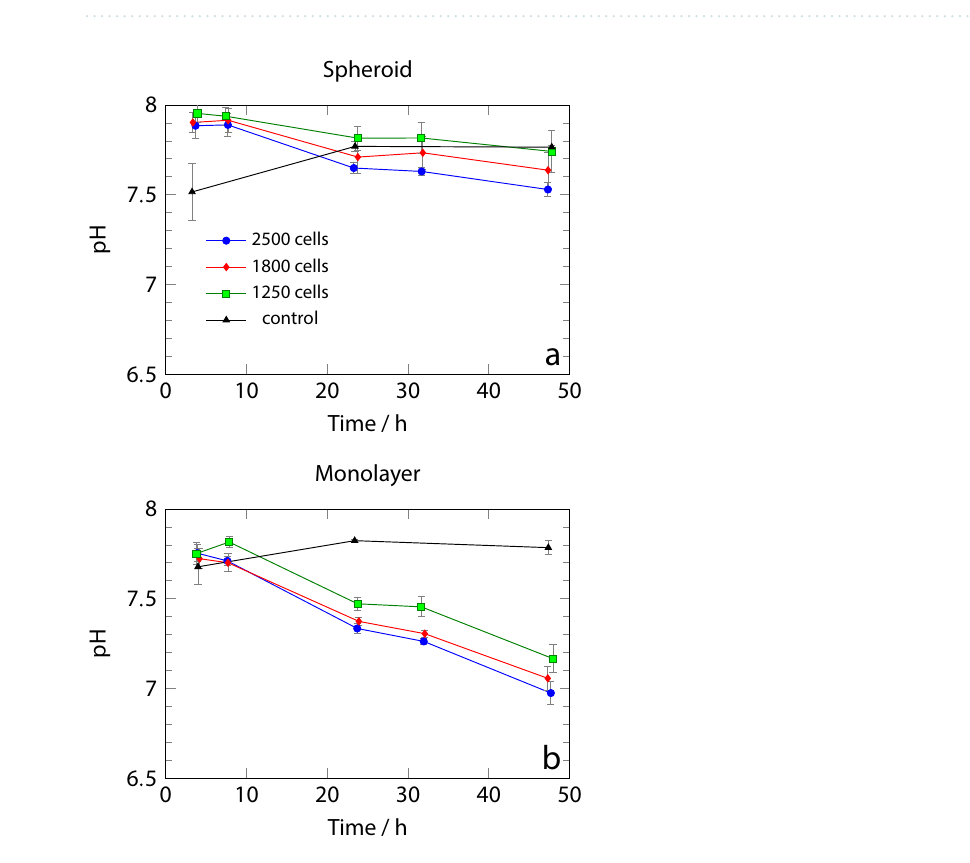
1 H Figure 3. 600 MHz NMR spectra obtained from a spheroid culture of about 2500 cells (seeding density of 1000 cells/ µ L) after 4 h, 24 h, and 48 h.